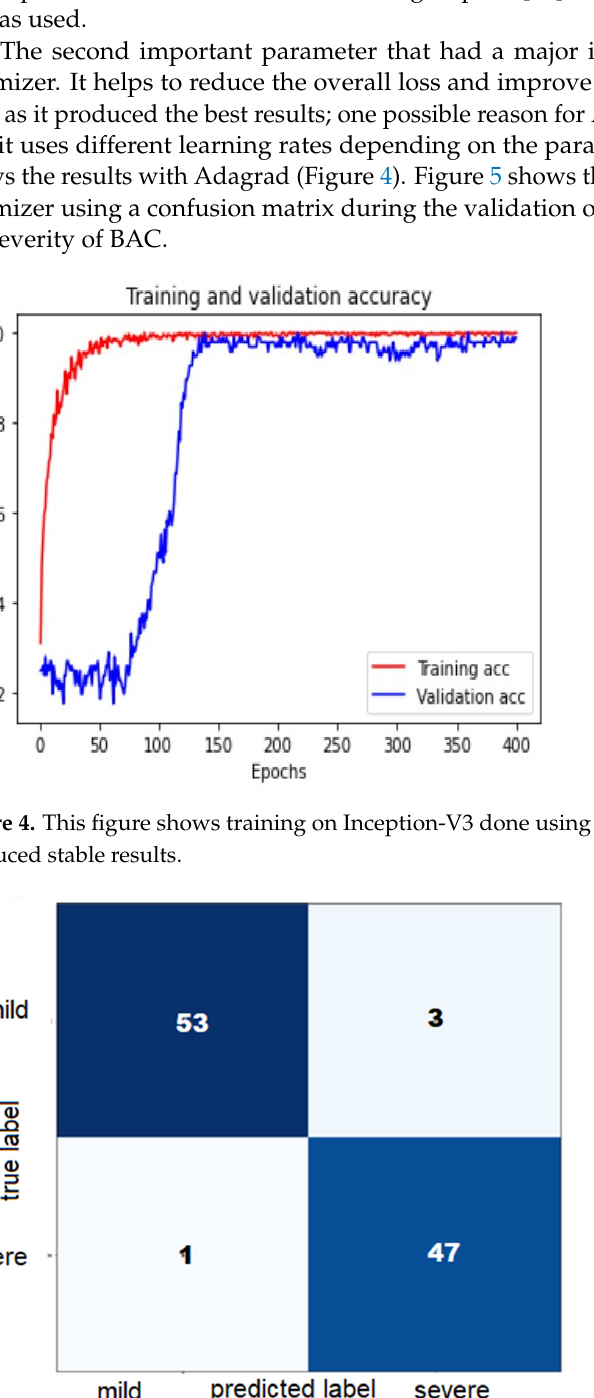
Figure 5. This figure shows the confusion matrix on Inception-V3 validation data in a 2-class classi-